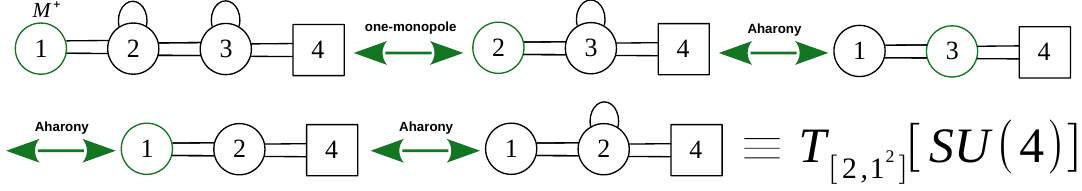
Figure 10 . Quiver representation of the sequential application of Aharony and one-monopole duality that leads to T [SU(4)] starting from its (cid:13)ip-(cid:13)ip dual T [2 ; 1 2 ]